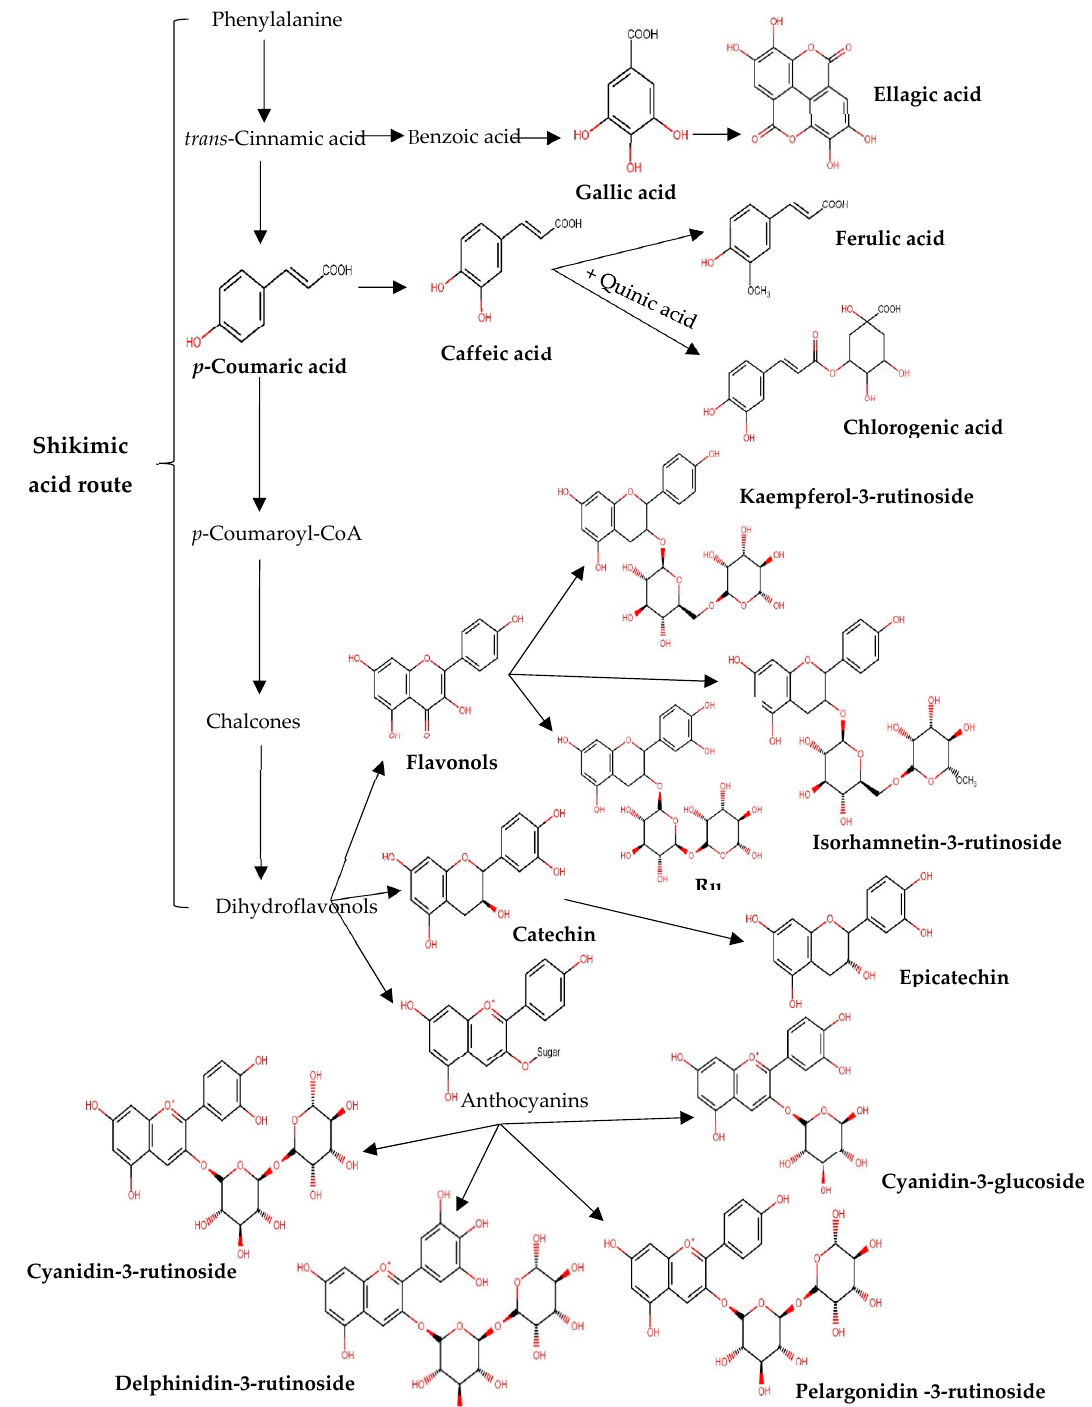
Figure 3. Outline of phenolics and anthocyanins biosynthesis from phenylalanine in tamarillos.